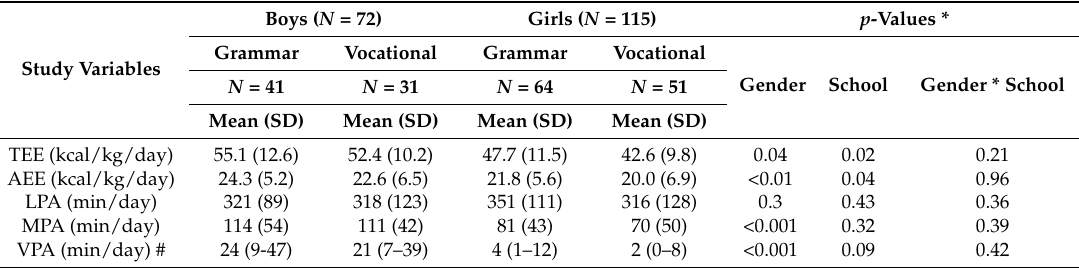
Table 2. Physical activity measures stratified by gender and the type of